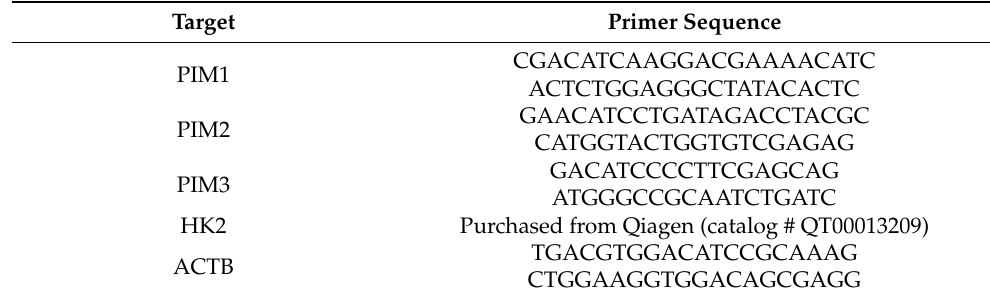
Table 1. Primer sequences used for quantitative polymerase chain